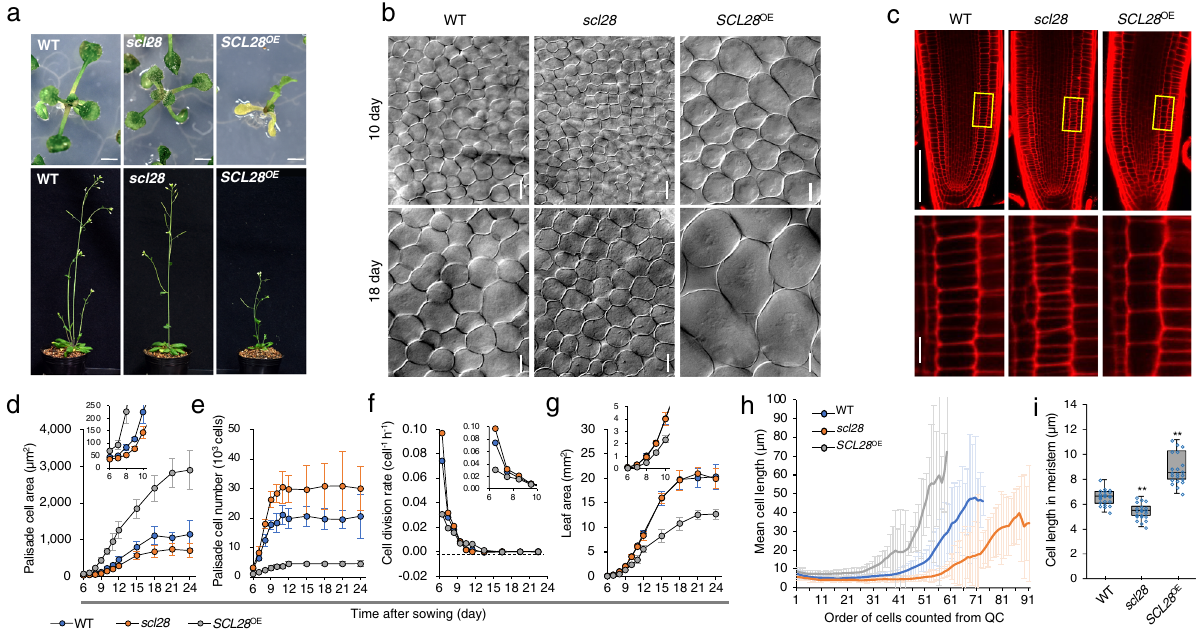
Fig. 2 SCL28 strongly affects cell size. a Macroscopic phenotypes caused by loss- and gain-of-function of SCL28 . WT, scl28 , and SCL28 OE plants were photographed at 11 (upper) and 30 (lower) DAS. Scale bar in upper panels indicates 10 mm. b Cell size analysis of leaf palisade tissue from WT, scl28 , and SCL28 OE plants. First leaf pairs from plants at 10 or 18 DAS were cleared and analyzed by differential interference contrast (DIC) microscopy. Scale bar indicates 20 µ m. c Cell size analysis of root meristem from WT, scl28 , and SCL28 OE plants at 5 DAS. Primary roots were stained with PI, and analyzed by CLSM. Regions surrounded by yellow rectangles are shown at a higher magni fi cation in the lower panels. Scale bars indicate 100 µ m (upper) and 10 µ m (lower). d – g Kinematic analysis of leaf growth in WT, scl28 , and SCL28 OE plants. Time-course changes of palisade cell area ( d ), number of palisade cells per leaf ( e ), cell division rate ( f ), and leaf area ( g ) were analyzed in developing fi rst leaf pairs. Values are averages from the data of leaves from ten different plants (±SD), in each of which more than 20 cells were analyzed. Inset shows the same data with an expanded y -axis scale. h Spatial distribution of cell size across root meristems in WT, scl28 , and SCL28 OE plants at 5 DAS. Mean cell length was calculated at each position along the cortical cell fi le, which is de fi ned by counts of cortical cells from the quiescent center. Values are averages from the data analyzed in 21 roots from different plants (±SD), in each of which more than 30 cells were analyzed. i Quantitative analysis of cortical cell length within root meristems. Boxplot was generated using data collected from roots of 21 different plants, in each of which more than 20 cells were analyzed. In boxplot, ‘ boxes ’ represent the interquartile range (IQR), midline indicates the median, and whiskers extend to the largest and smallest observations within 1.5 × IQR. Statistical signi fi cance compared with WT was determined using two-sided Student ’ s t test. ** P <